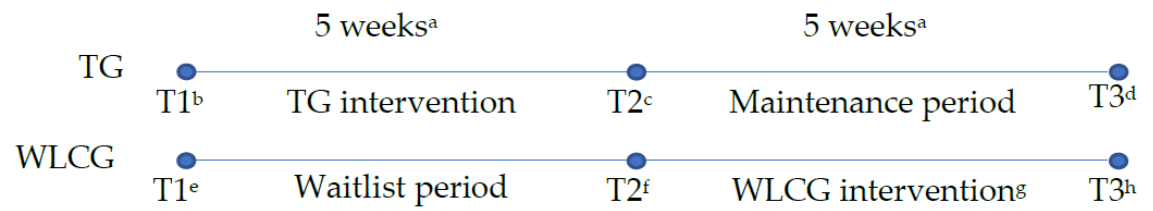
Figure 1. Intervention timeline and assessment time points for the treatment group (TG) and waitlist control group (WLCG). a 5 weeks indicates the length of the intervention period. b T1 for the TG represents the baseline assessment. c T2 for the TG represents the post-intervention assessment. d T3 for the TG represents the maintenance period. e T1 for WLCG represents the waitlist period. f T2 for WLCG represents the baseline assessment. g Same intervention as the TG. h T3 for WLCG represents the post-intervention assessment.